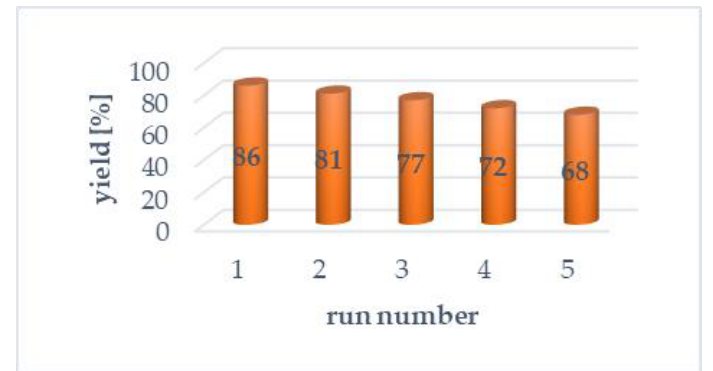
Figure 2. Reuse of the Novozym 435 catalyst.